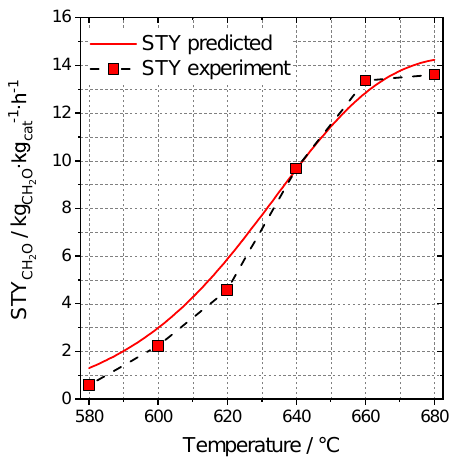
Figure 9. Predicted and experimental space-time yield at 960,000 L · kg − 1 · h − 1 , 10% O 2 , 0% N 2 and 20% H 2